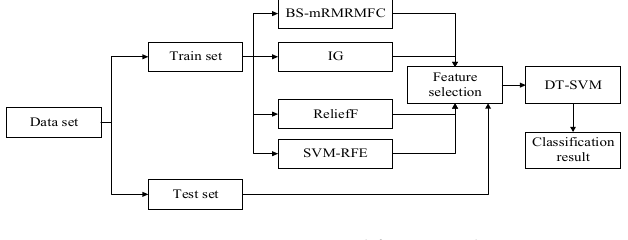
Figure 10. Experimental framework.